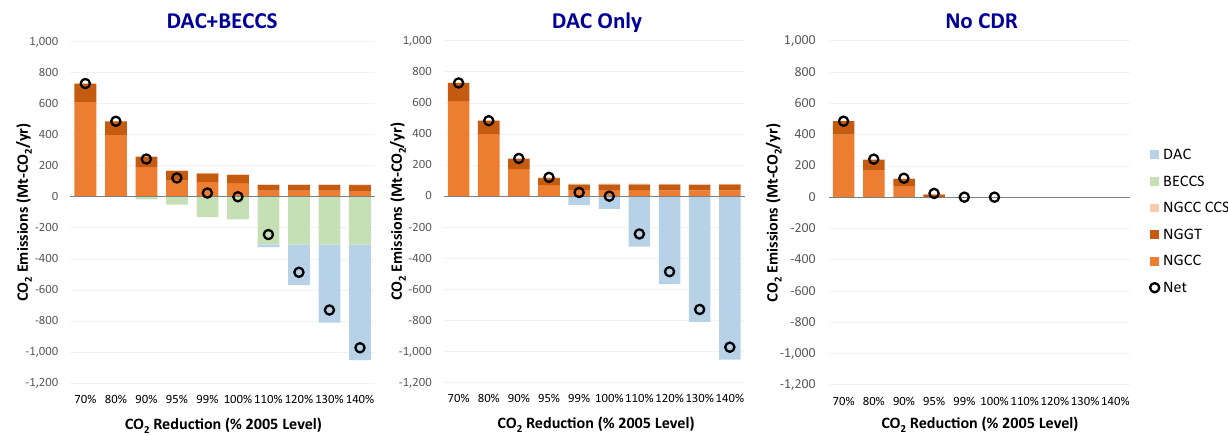
Fig. 6 CO 2 emissions by technology across different electric sector reduction targets (% reductions relative to 2005 levels) and assumptions about CDR availability. Net emissions from bioenergy with carbon capture and sequestration (BECCS) and direct air capture (DAC) are negative, while emissions from natural-gas- fi red combined cycle (NGCC), CCS-equipped gas (NGCC CCS), and gas turbines (NGGT) are positive. Note that emissions reductions beyond 100% are not feasible in the cases without CDR. Source data are provided as a Source Data